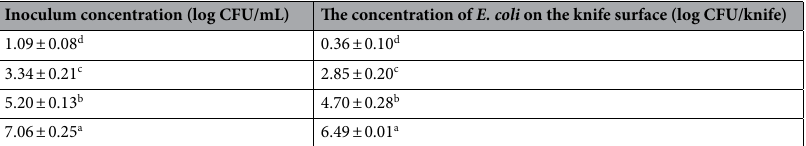
Table 1. Concentration of E. coli inoculated on a kitchen knife. Different letters respectively represent statistically significant differences between different inoculation concentrations and infection concentrations ( p <